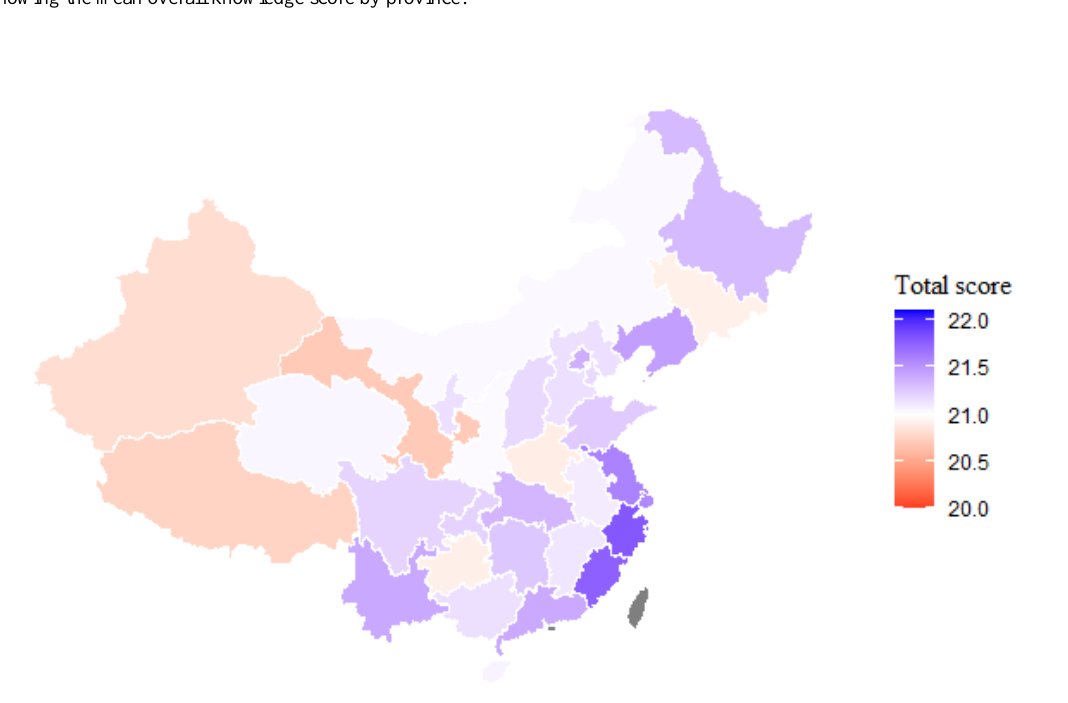
Figure 1. Map showing the mean overall knowledge score by